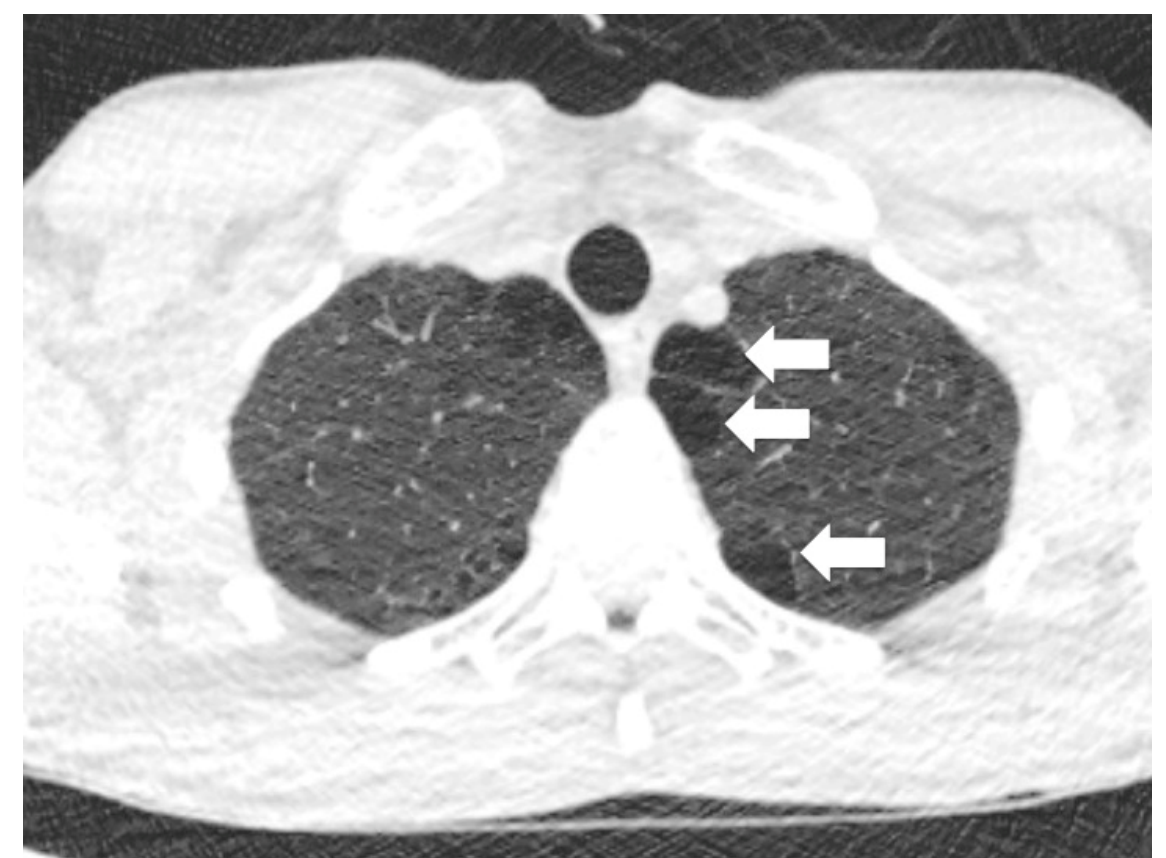
Figure 1. Computed tomography (CT) image demonsrates apical blebs. Arrows show multiple blebs (which are termed paraseptal emphyema when contigunous).